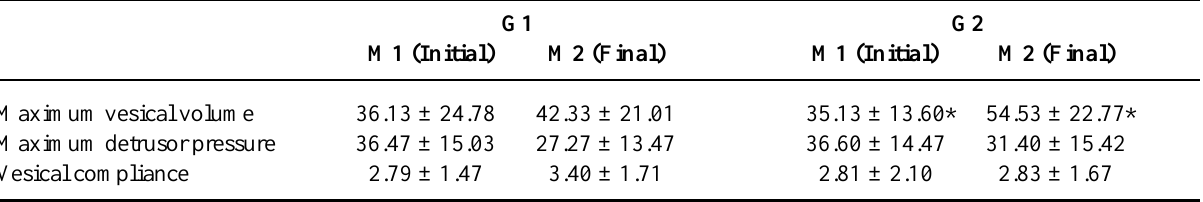
Table 1 – Maximum vesical volume (mL), maximum detrusor pressure (cm H rabbits. Mean and standard deviation of cystometric parameters in the beginning (M1) and 4 weeks after surgery (M2) in group G1 (control) and G2 (infravesical obstruction).